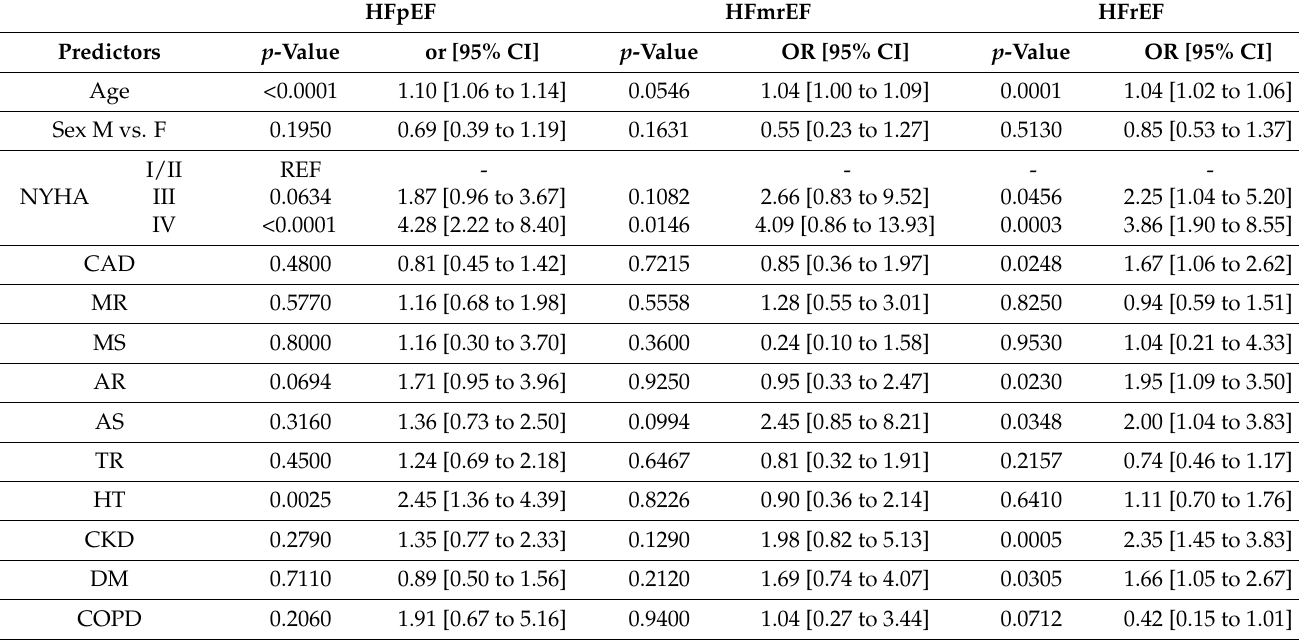
Table 2. Predictors of one-year mortality in patients with HF and AF, according to the LVEF.